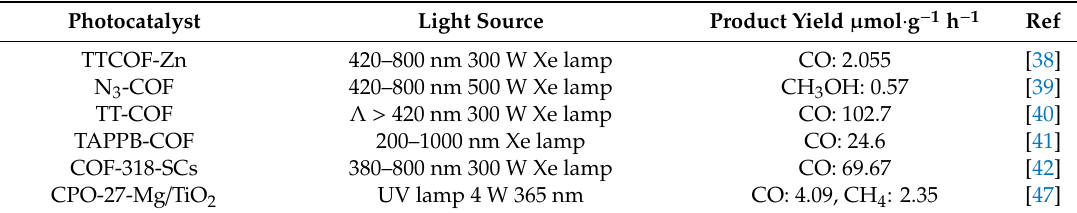
Table 3. The summary of photocatalytic CO 2 reduction e ffi ciency using H 2 O as electron-donor for COFs and other semiconductor materials